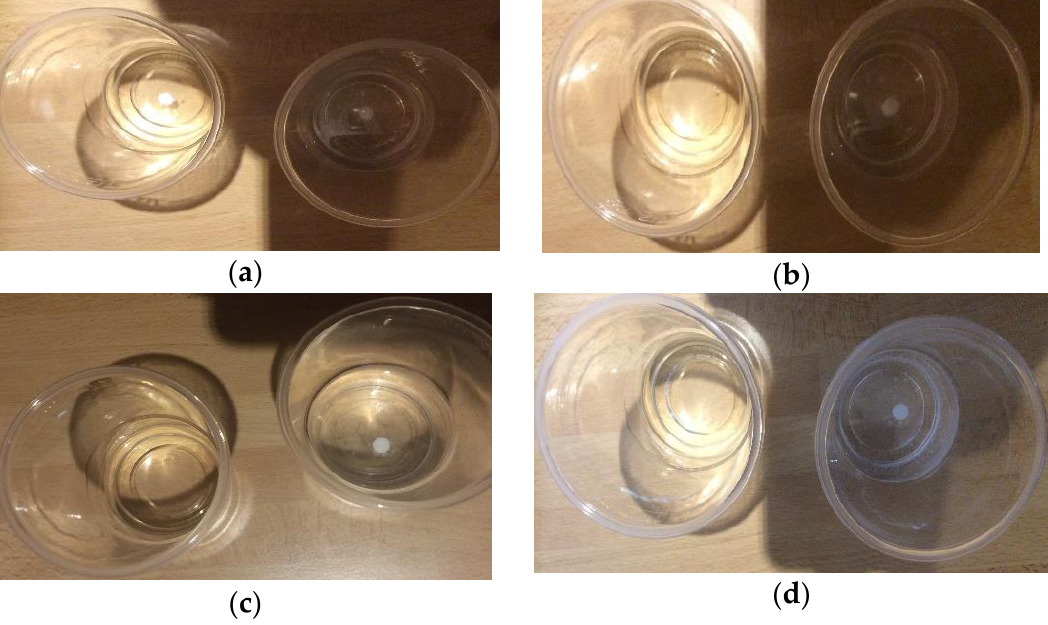
( d ) Figure A2. Drop test showing emulsions of droplets deposited on pure sunflower oil: ( a ) at the start of the test; ( b ) after 3 min, when the emulsion droplet was partially dispersed, but to some extent maintained its original shape; ( c ) after 4 min, when the emulsion droplet was partially dispersed and losing it original integrity, shape and size; and ( d ) after 5 min, when the emulsion droplet was further dispersed and transformed into a number of smaller emulsion droplets. Appendix B T-Statistic calculation: Hypothesis: treatment 10/14 is better than treatment 2/7 by at least 13 days.